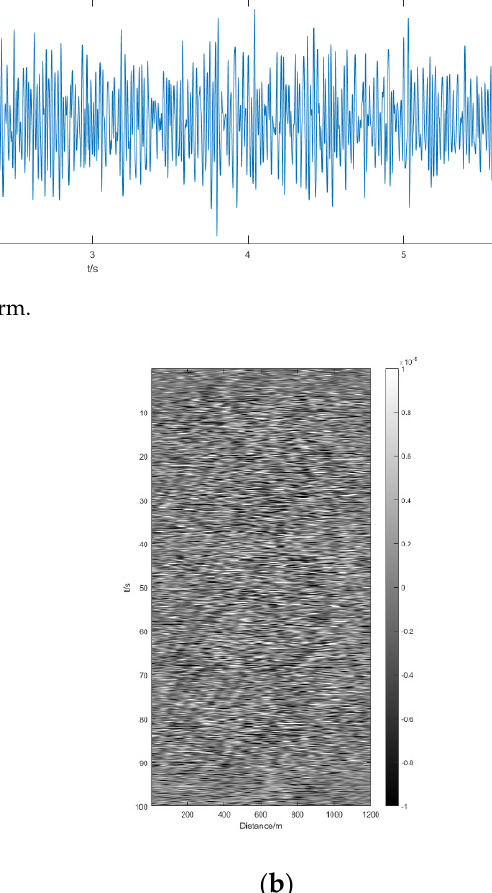
Figure 3. Short ‐ period passive seismic recording and long ‐ period passive seismic record. ( a ) Passive Figure 3. Short-period passive seismic recording and long-period passive seismic record. ( a ) Passive seismic records with short periods; ( b ) passive seismic records with long periods. seismic records with short periods; ( b ) passive seismic records with long